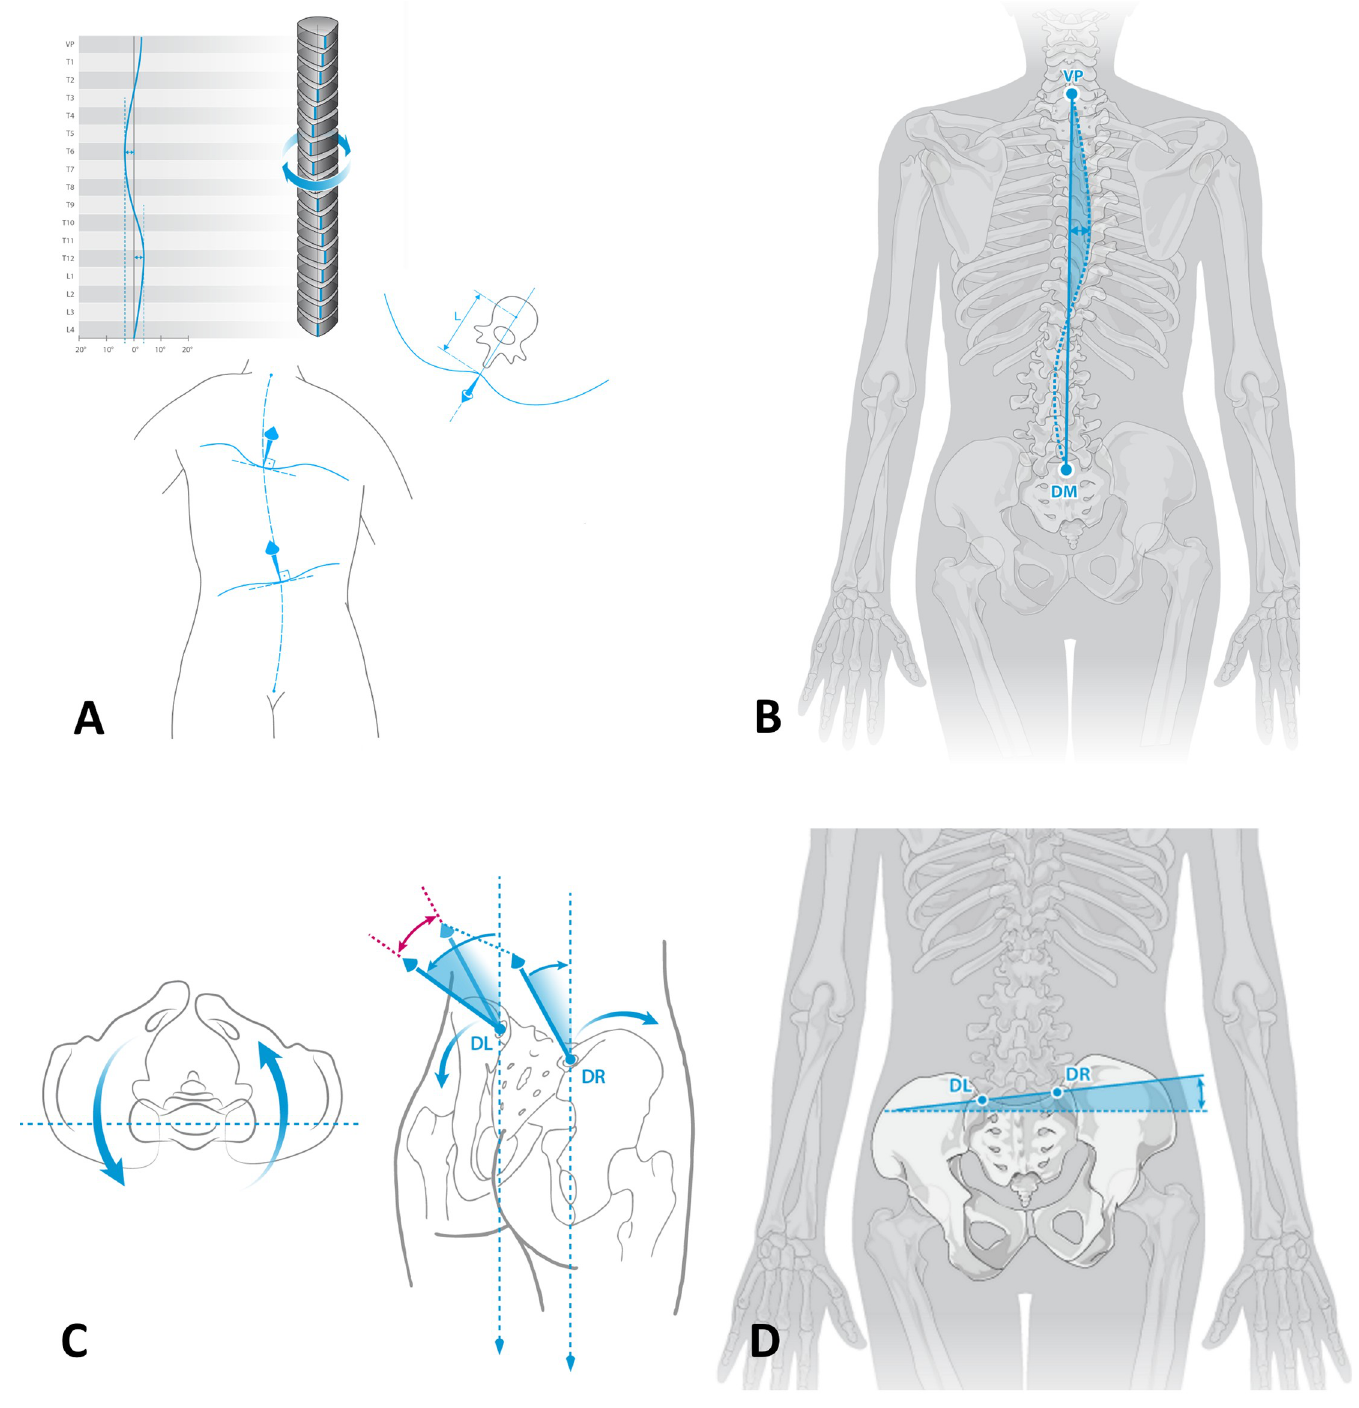
Fig 2. Surface rotation (A) of the spine is defined as the value of the horizontal components of the surface normals on the line connecting the spinous processes of the spine. Lateral deviation of the spine (B) is the deviation of its midline from a virtual line between vertebra prominence (C7) to the midpoint between left and right lumbar dimple. Pelvic torsion (C) is the torsion of the surface normals on the two lumbar dimples. Pelvic obliquity (D) is considered as the different height of the two lumbar dimples to each other.